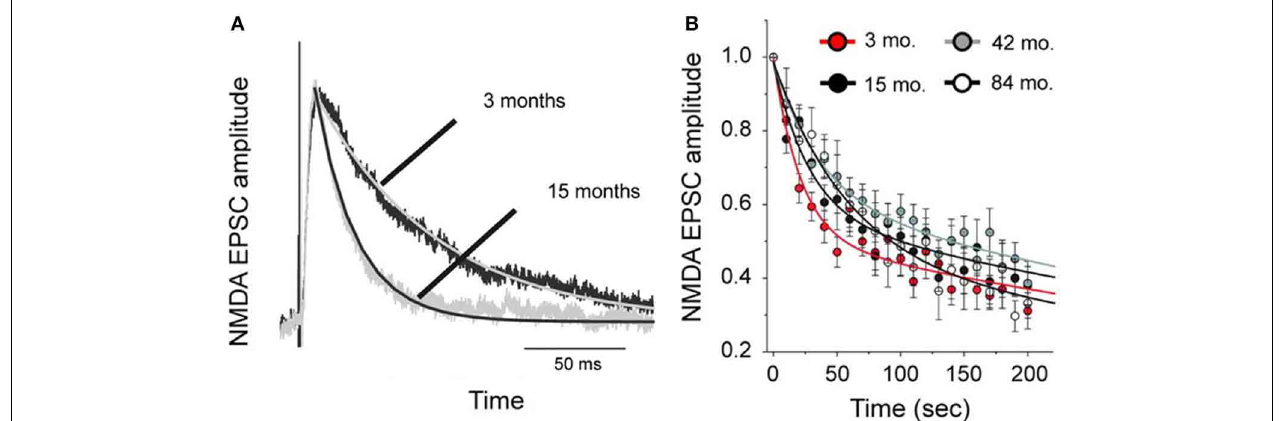
FIGURE 10 | Age differences in cell physiology. Plots of the difference in NMDA-mediated excitatory postsynaptic currents (NMDA-EPSCs) in pyramidal cells sampled from the prefrontal cortex of 3 and 15 month old macaque monkeys. (A) Examples of average NMDA-EPSCs scaled to the same peak amplitude illustrating the exponential functions fit to the traces. Note the